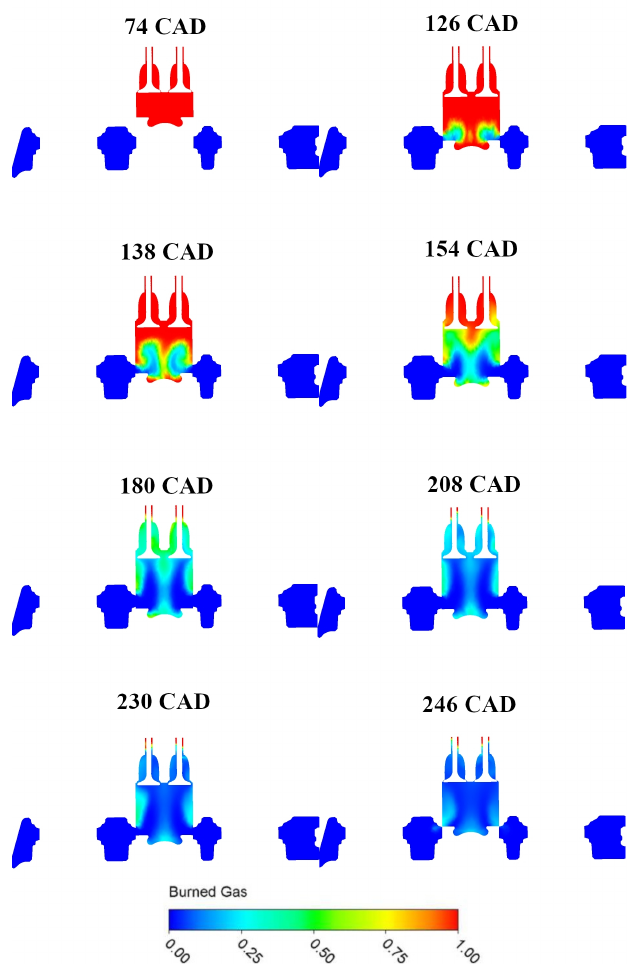
Figure 10. Contour plot of the Burned Gas mass fraction at several instants on the plane XY.